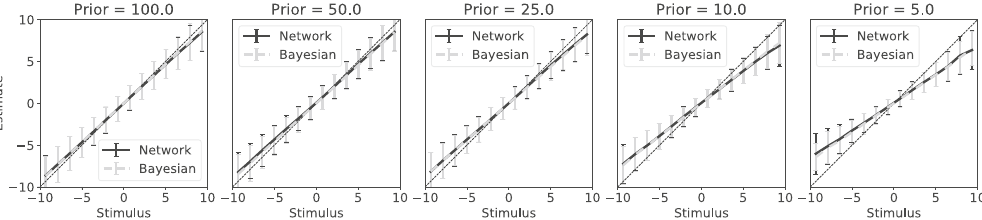
Figure 9. Learned prior causes perceptual bias that is statistically optimal. The network biased its estimates of the stimulus towards the mean of the prior (solid line). This effect was strongest for the sharpest prior ( σ 2 p This perceptual bias matched the bias predicted by an optimal Bayesian observer (dashed line, note overlap with solid line). Error bars represent standard deviation over the validation